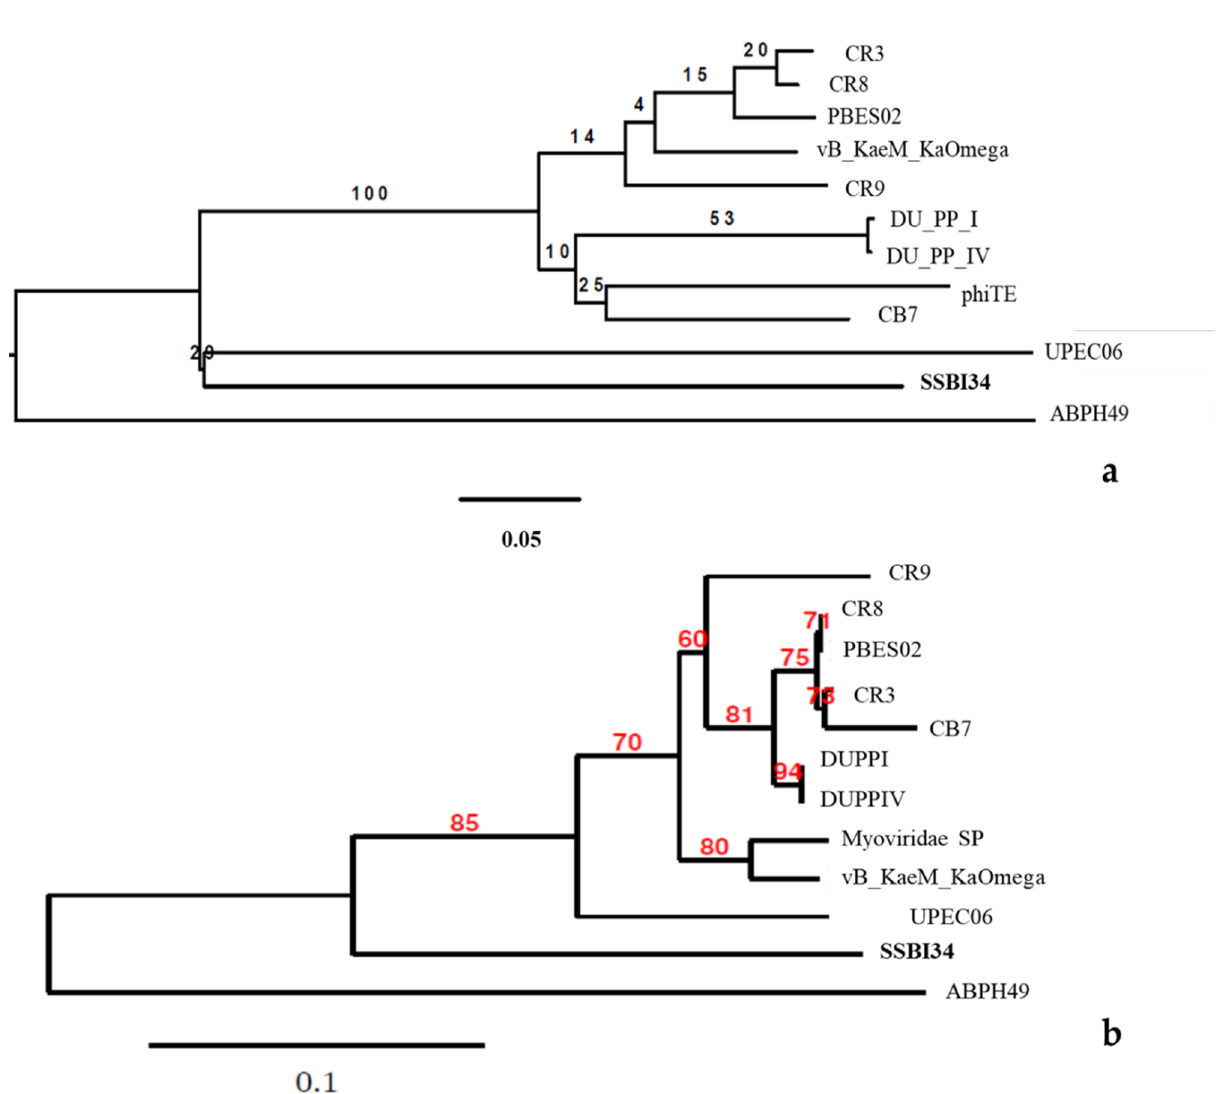
Figure 6. ( a ) The BLAST distance tree using whole-genome sequence of 12 homologs in BLSTn provides a rough estimate of the relationships between related sequences in NCBI and Salmonella - phage-SSBI34. ( b ) Phylogenetic tree using the capsid protein gene of these closest homologs.